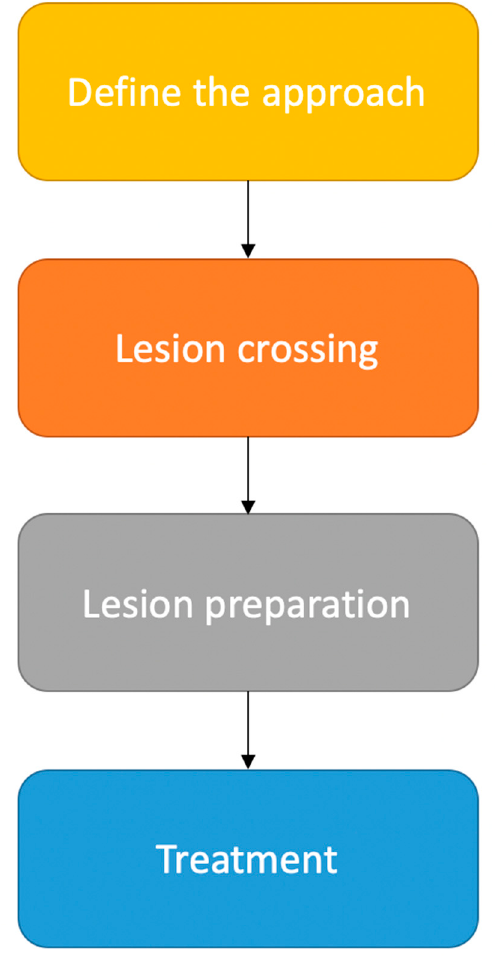
Figure 1. Strategy for endovascular treatment of femoropopliteal